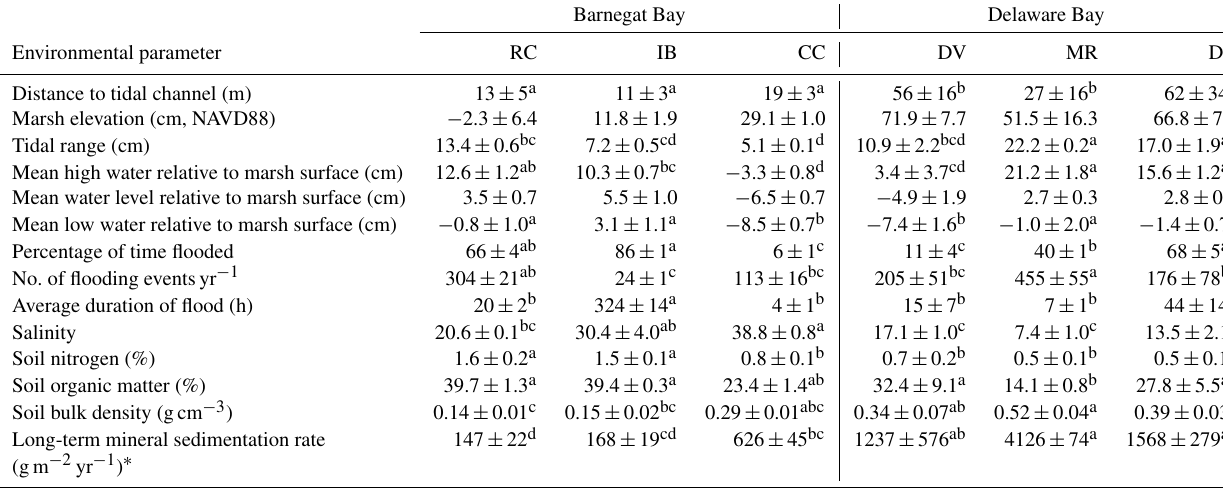
Table 1. Environmental conditions of interior Spartina alterniflora -dominated marshes in two estuaries of the mid-Atlantic, USA. Values are means ± standard errors ( n = 2 for hydrologic parameters and n = 3 for soil and elevation and soil parameters). Parameter values across marshes represented by different letters are significantly different based on nested analysis of variance ( p <0.05).